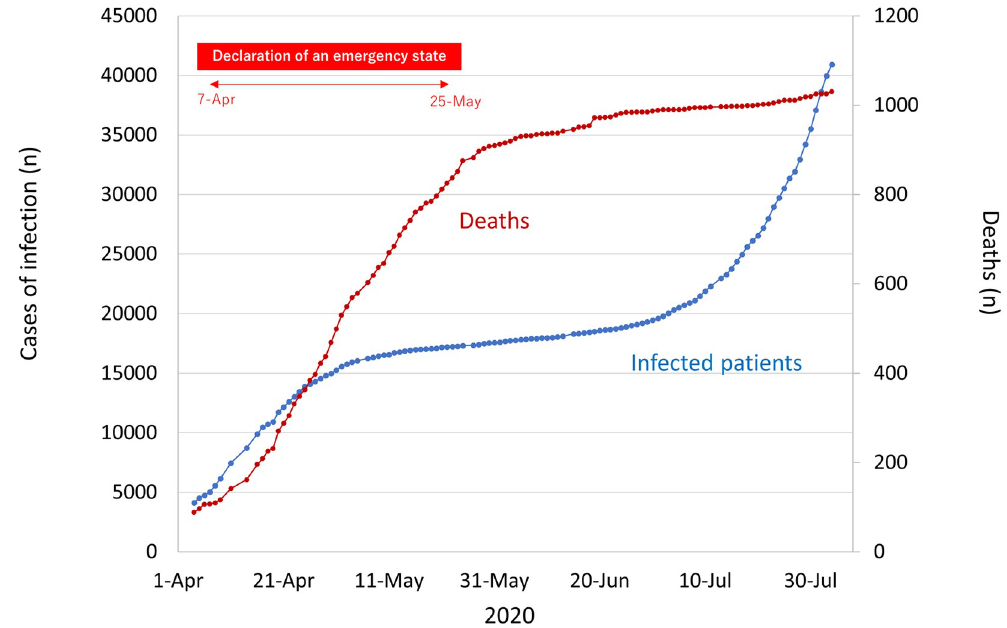
Fig 1. Cumulative number of patients and deaths due to COVID-19 in